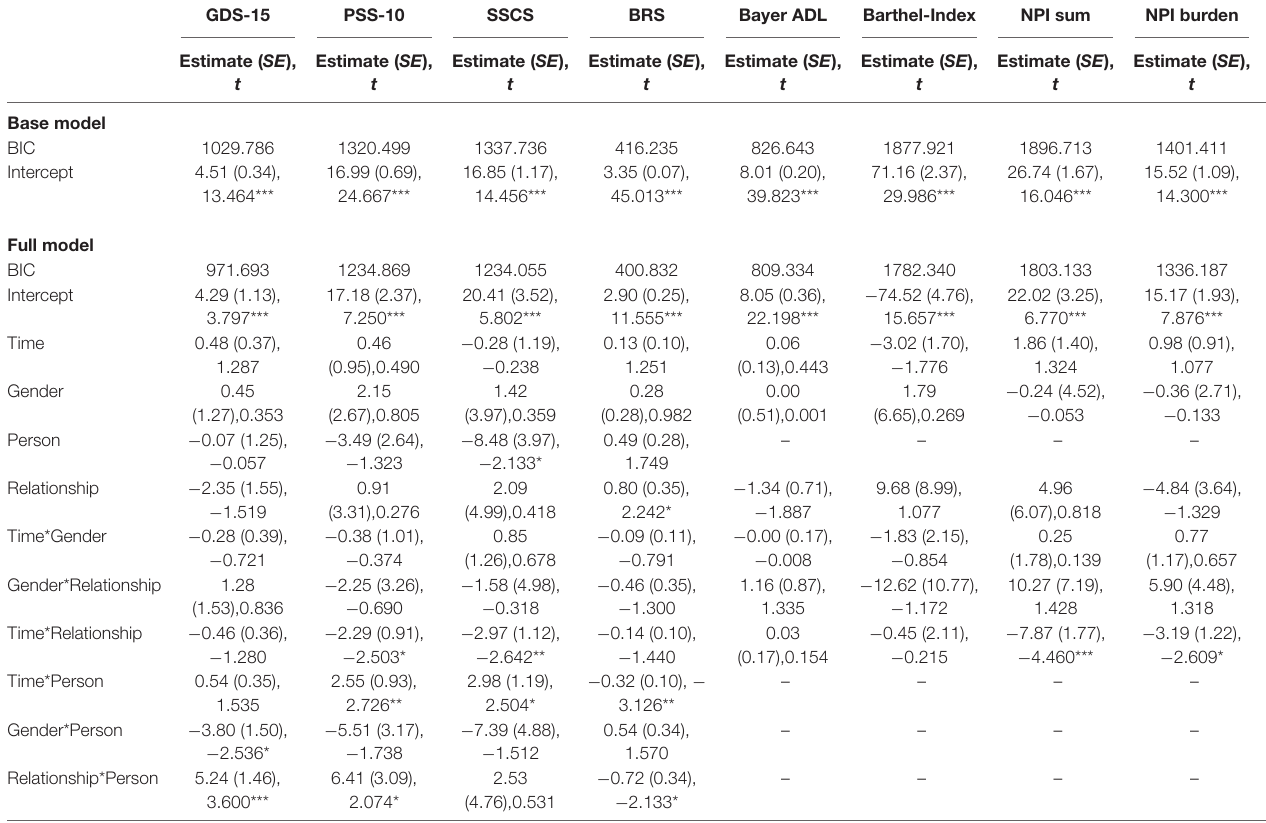
TABLE 2 | Results of linear mixed models predicting changes in psychometric test battery depending on time (admission, discharge, and follow-up), person (PwD and IC), and relationship (spousal dyad and child–parent dyad). GDS-15 PSS-10 SSCS BRS Bayer ADL Barthel-Index NPI sum NPI burden Estimate ( SE ), Estimate ( SE ), Estimate ( SE ), Estimate ( SE ), Estimate ( SE ), Estimate ( SE ), Estimate ( SE ), Estimate ( SE ), t t t t t t t